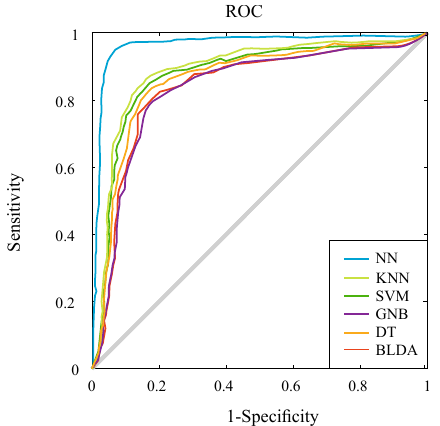
Figure 4. ROC curves for the 9 classification systems compared.